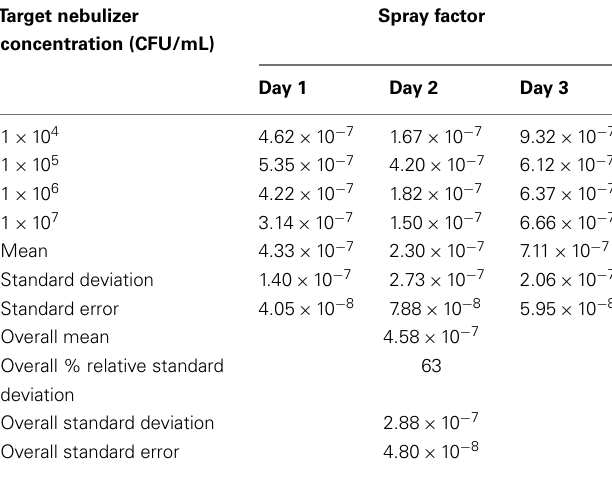
Table 1 | Pilot feasibility study mean spray factor